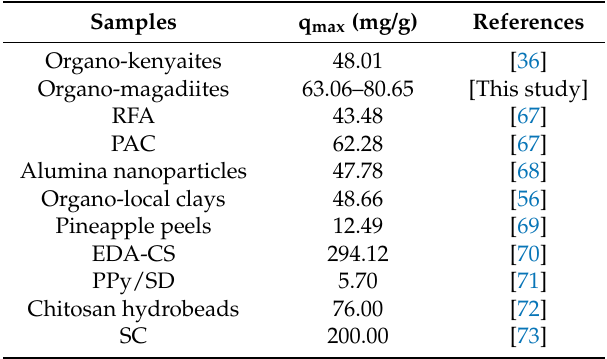
Table 4. Removal capacities of various adsorbents for eosin